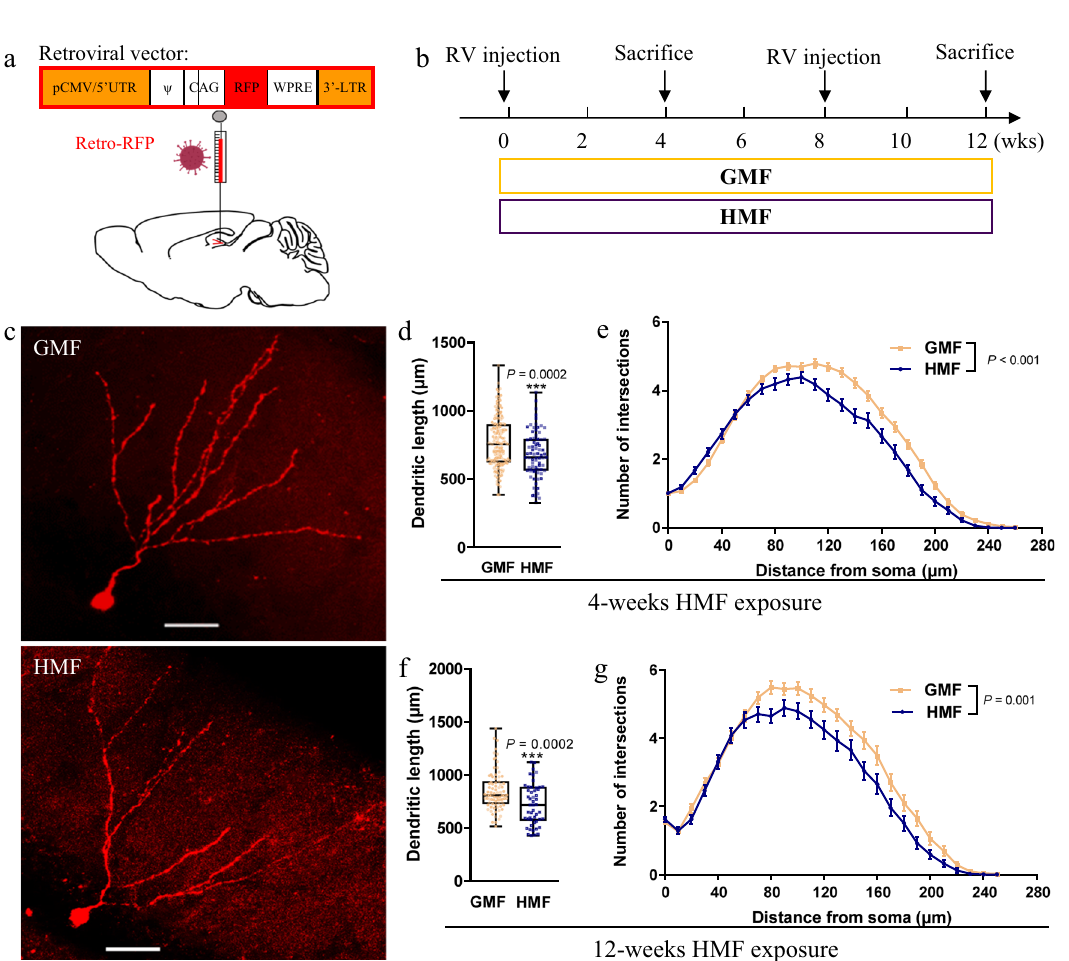
Fig. 3 Long-term HMF exposure impaired the dendritic development of newborn neurons in the DG. a Schematic diagram of the retroviral vector and stereotaxic grafting of retrovirus into the DG of adult mice. b Experiments timeline for the in vivo labeling and analyses of newborn neurons in the DG of GMF- and HMF-exposed mice. c Representative images of RFP + newborn neurons in the DG of GMF- and HMF-exposed mice at 4-weeks post retrovirus injection. Scale bar = 50 μ m. d , e Quanti fi cation of the dendritic length ( d ) and dendritic complexity ( e , GMF versus HMF, UNIANOVA, F(1, 242) = 15.19 P < 0.001) of RFP + newborn neurons in the adult DG of mice during 4-weeks GMF and HMF exposure. GMF, n = 167 neurons from four mice, HMF, n = 77 neurons from four mice. Data were analyzed by UNIANOVA analysis, and the two-tailed unpaired t test for two-group comparisons. f , g Quanti fi cation of the dendritic length ( f ) and dendritic complexity ( g , GMF versus HMF, UNIANOVA, F(1, 131) = 10.76, P = 0.001) of RFP + newborn neurons in the adult DG of mice during 12-weeks GMF and HMF exposure. GMF, n = 82 neurons from four mice, HMF, n = 50 neurons from four mice. Data were analyzed by UNIANOVA analysis, and the two-tailed unpaired t test for two-group comparisons. The data in ( d , f ) were presented in the whisker plot with de fi ned elements, median (centerline), upper and lower quartiles (bounds of box), and highest and lowest values (whiskers). Other data are presented as mean ±